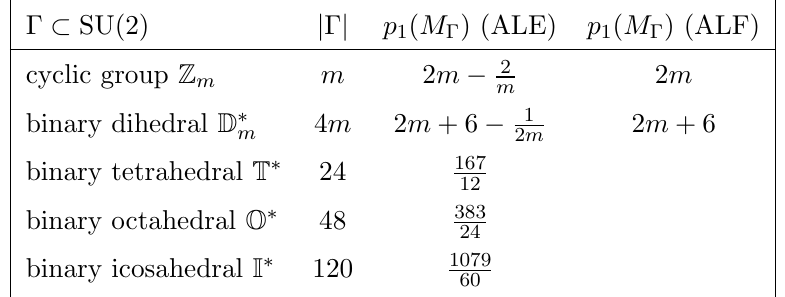
Table 1 . The freely acting discrete subgroups of SU(2), their sizes and the (cid:12)rst Pontryagin numbers of the di(cid:11)erent ALE and ALF spaces M (cid:0) . The empty entries signify that such a space does not